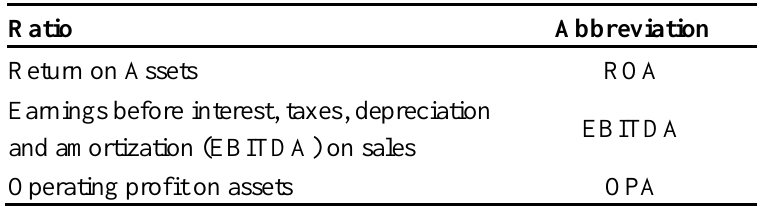
Table 5. Analyzed